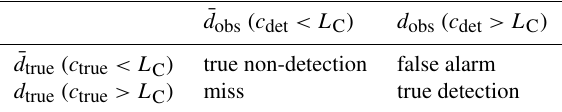
Table 2. Definition of a true non-detection, a miss, a false alarm, and a true detection based on the Currie critical level L C , the de- tected activity concentration c det , and the “true” activity concentra- tion c true , which will never be